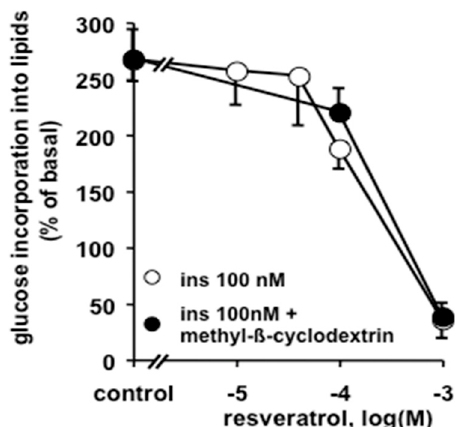
Figure 6. Inhibition of mouse adipocyte lipogenesis by resveratrol is not influenced by cholesterol depletion. Incorporation of 3 H-glucose into adipocyte lipids was measured after 120 min with 100 nM insulin, 1 mM methyl- β -cyclodextrin, and the indicated increasing doses of resveratrol. Data were expressed as percentage of basal lipogenesis, set at 100%. The x axis represents the logarithm of resveratrol concentration in M. Each point is mean ± SEM of at least 10 preparations. No significant effect of methyl- β -cyclodextrin (black circles) was found on resveratrol inhibition of insulin-stimulated lipogenesis (open circles).